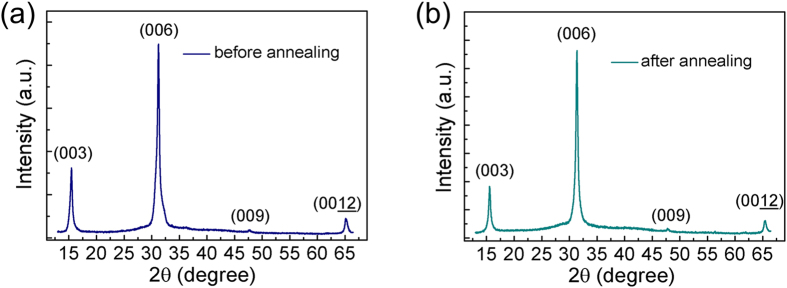
XRD patterns of the CuGaO2 nanoplates sample (a) before annealing and (b) after 400 °C annealing in air.